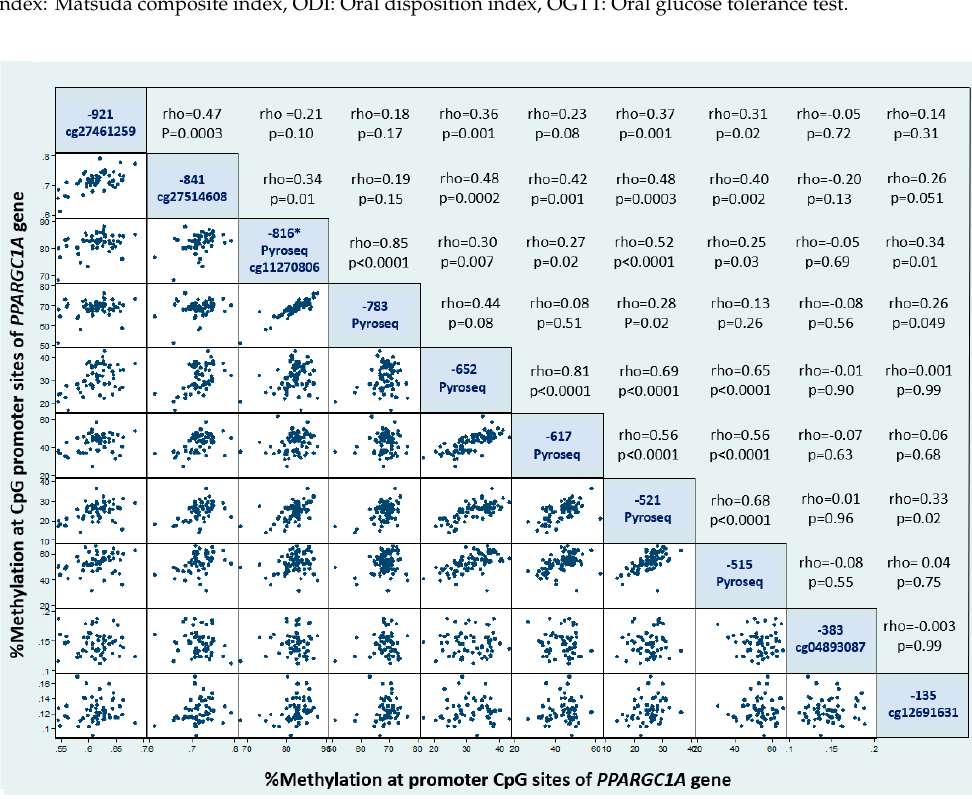
Figure 2. Scatter plots showing the methylation levels of CpG sites at the PPARGC1A promoter in leukocytes. * Pyrosequencing measurements were used for methylation levels at the -816 CpG position in this chart.